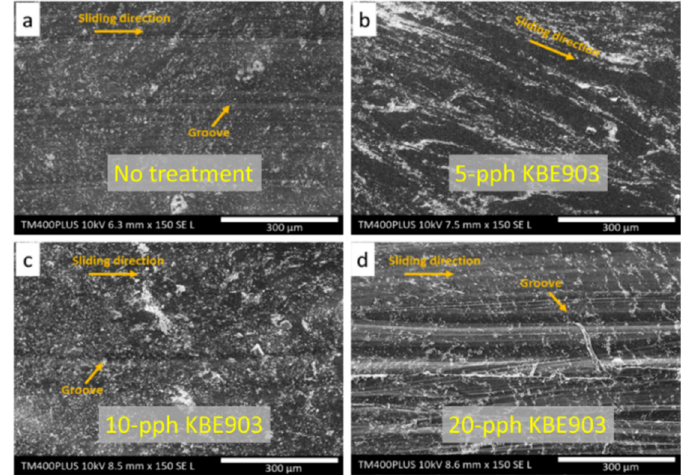
Figure 6. SEM images showing wear tracks of ( a ) non-treated Sm 2 O 3 /UHMWPE composites and treated Sm 2 O 3 /UHMWPE composites with ( b ) 5 pph KBE903, ( c ) 10 pph KBE903, and ( d ) 20 pph KBE903. All images are at a magnification of ×150.